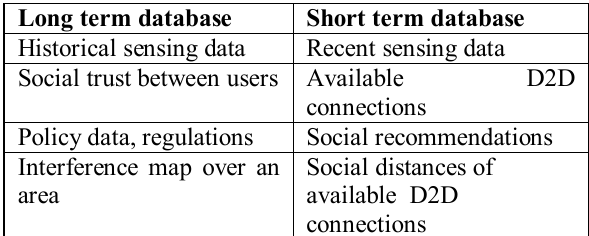
Table II. Data to be included in databases.